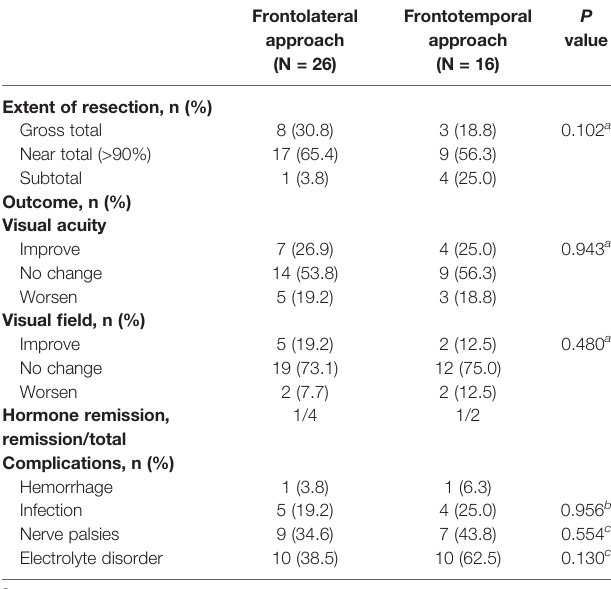
TABLE 6 | Outcome and complications between different surgical approach. Frontolateral